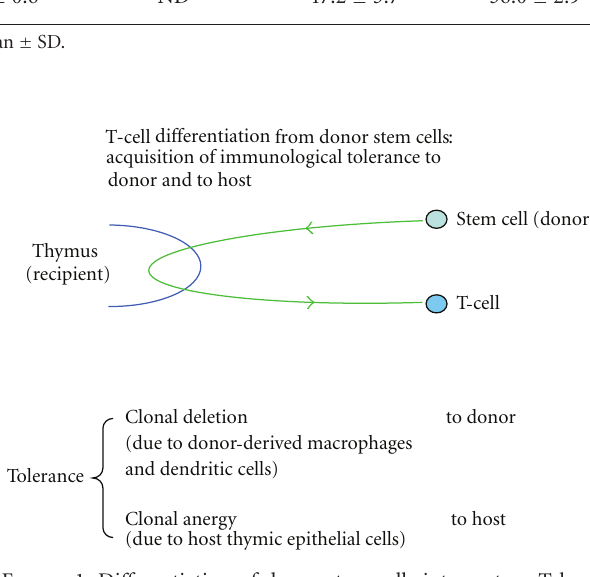
Figure 1: Di ff erentiation of donor stem cells into mature T lym- phocytes within the host thymus: acquisition of tolerance by thy- mocytes in contact with other donor cells and with host thymic epithelial